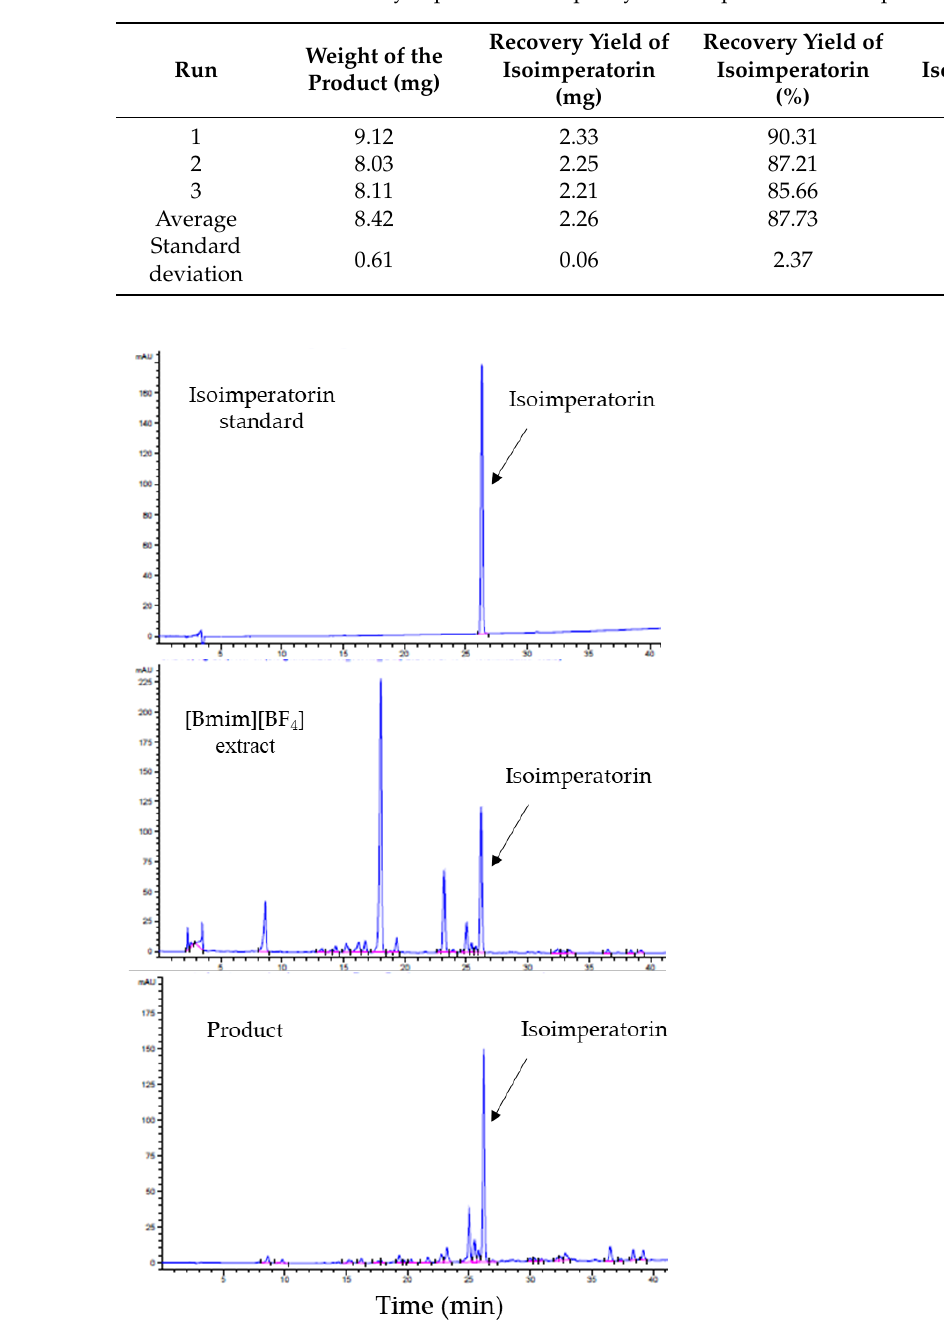
Figure 5. HPLC chromatographic spectra of isoimperatorin standard, the [Bmim][BF 4 ] extraction solution and the product at 254 nm.